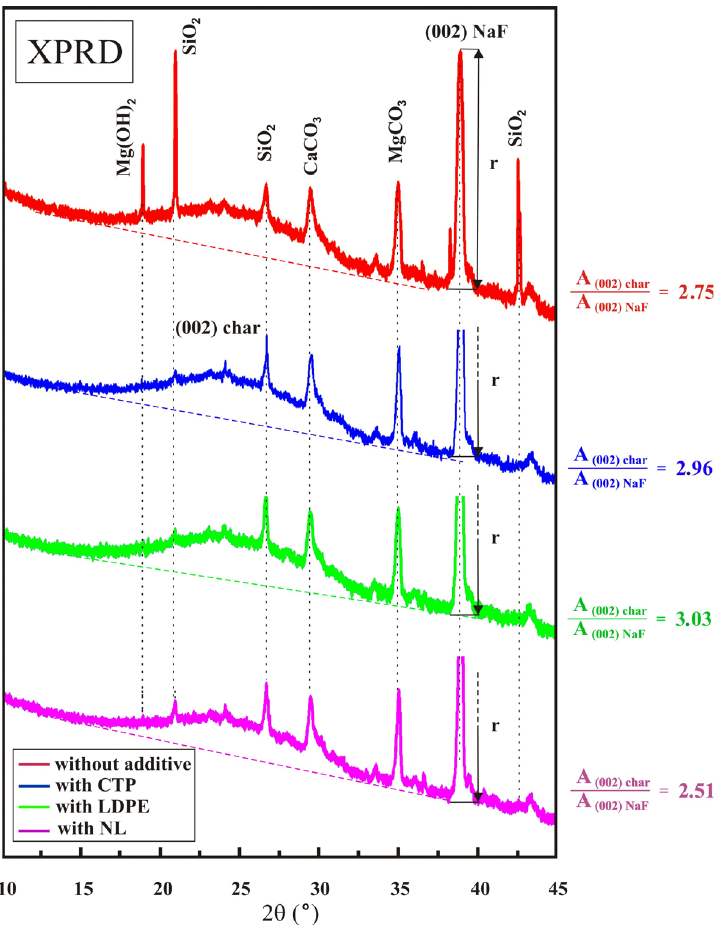
Figure 8. The diffractograms of chars of densified PH sample and its blends with additives that were pyrolysed to a temperature of 450 °C.